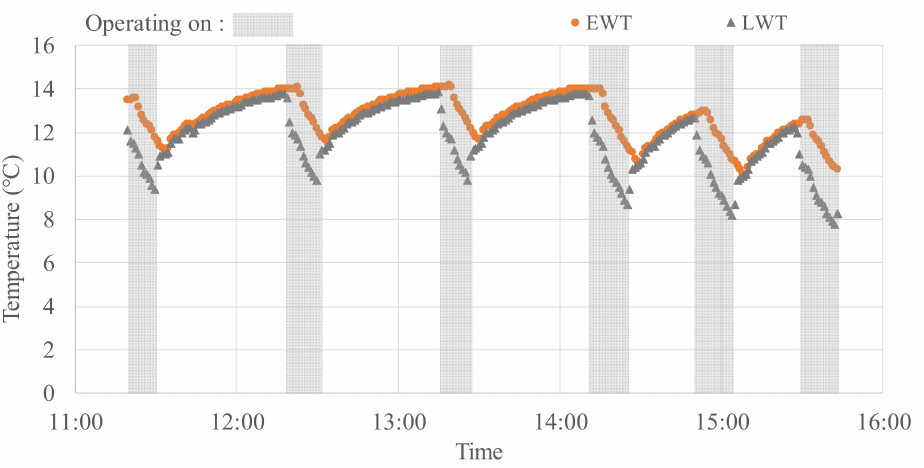
Figure 9. Fluctuation of EWT and LWT in Case